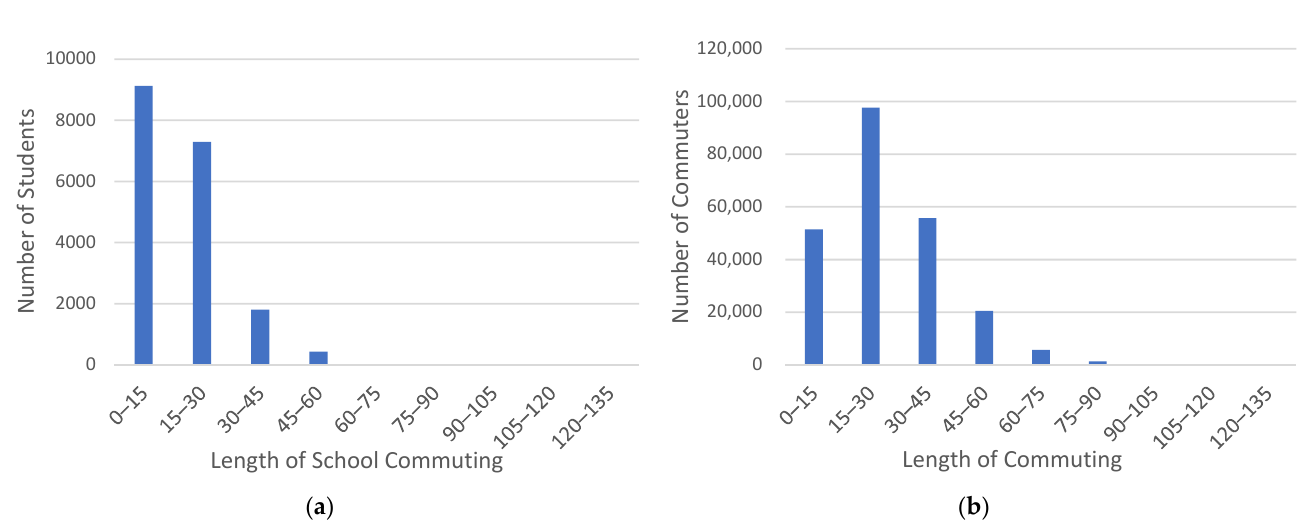
commuting; ( b ) Distribution of commuters’ length of commuting. ( b ) Distribution of commuters’ length of